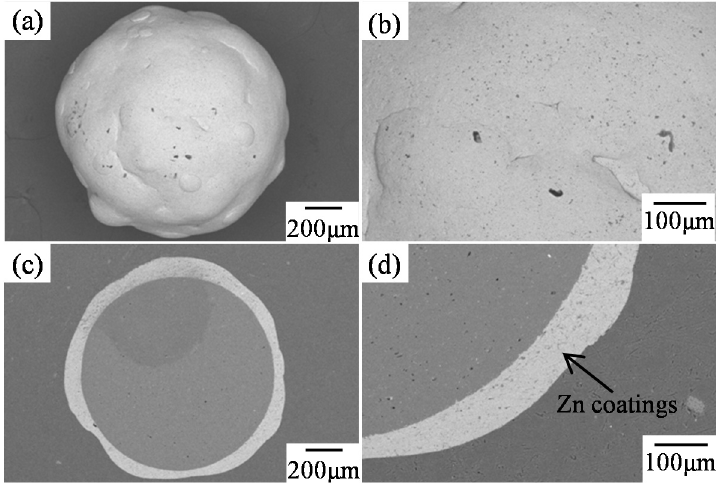
Figure 11. Zn coatings by MCT at 300 rpm for 12 h. ( a , b ) Surface structure; ( c , d ) Cross sectional